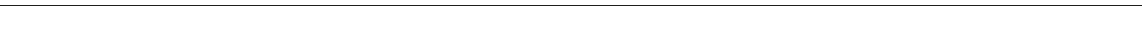
Fig. 6 Bub1 regulates CENP-AS7 phosphorylation and Aurora-A targeting at centromeres. a , b HeLa cells depleted of Bub1 by siRNA were immunostained with anti-p-CENP-AS7 ( a ) or anti-Aurora-A ( b ) and CREST antibodies. Magni fi cations (× 9) of single chromosomes are shown. Means ± SEM are shown (on the right of the panel) for the quanti fi cation of signal intensity relative to CREST obtained with antibodies against p-CENP-AS7 or Aurora A antibodies in a representative experiment (for p-CENP-AS7 intensity, n = 20 cells in each condition; for Aurora A intensity, n = 25 cells in control and 20 cells in Bub1 RNAi conditions; **** P < 0.0001; two-tailed unpaired nonparametric Mann – Whitney U -test). c Metaphase chromosome spreads from CENP-A-HA-WT, CENP-A-HA-S7A, and CENP-A-HA-S7D cell lines depleted of Bub1 were immunostained with antibodies against Bub1 and Sgo1. Scale bar = 5 µ m. Inter- kinetochore distance means ± SEM of fi ve to six representative cells with joined SC are shown ( n = 10 – 50 chromosomes for each cell). Statistical analysis were performed on the mean of the distance measured for each cell ( n = 5 – 6; **** P < 0.0001; *** P < 0.001; NS, not signi fi cant; two-way ANOVA